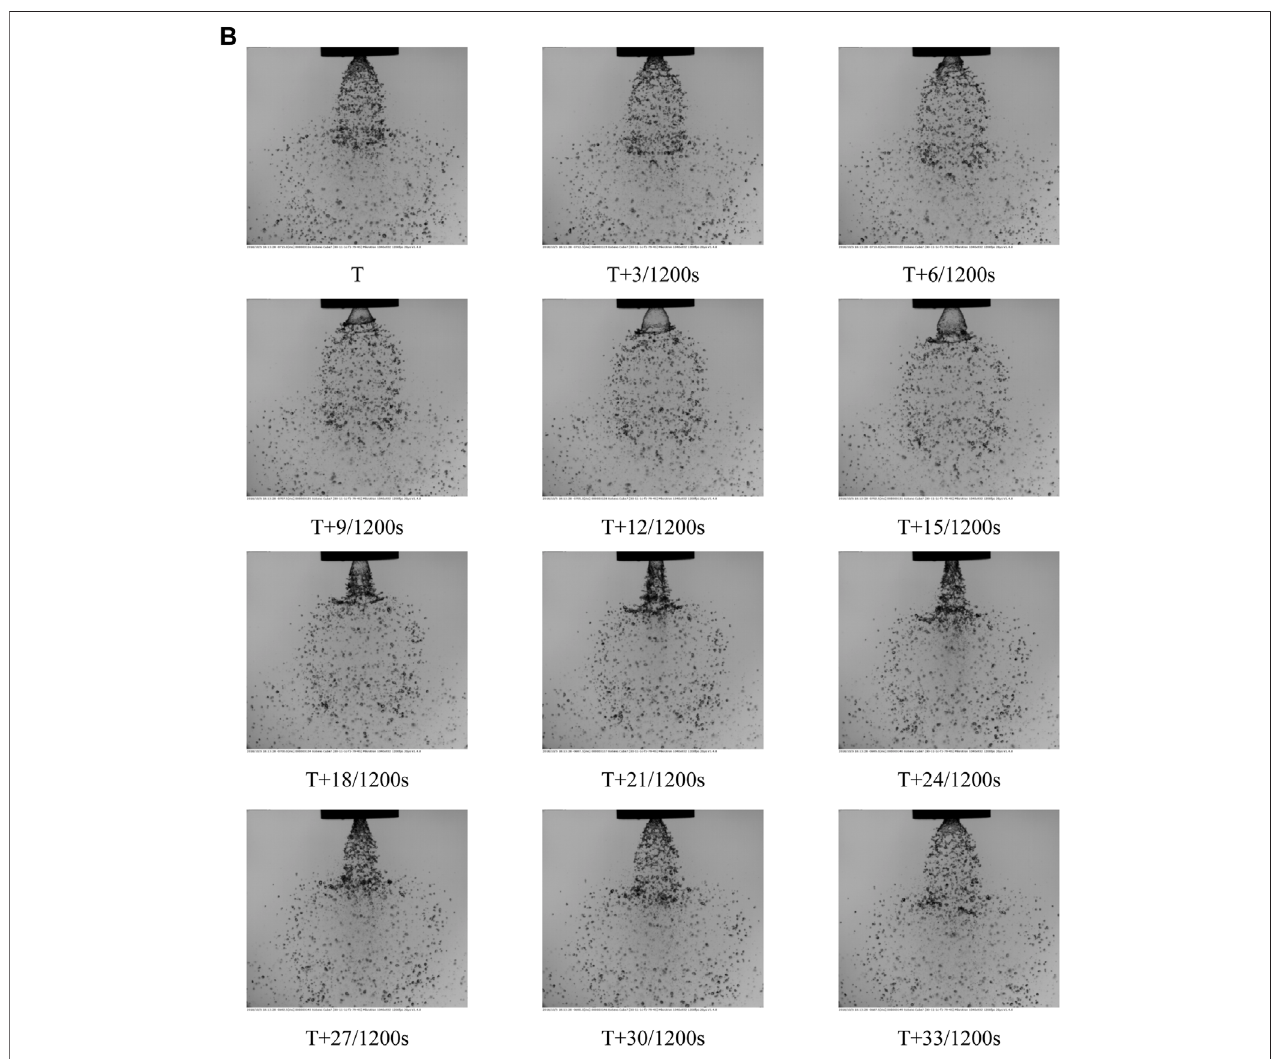
liquid fi lm morphology. The lower part of the spray then disappears and the liquid fi lm begins to break when the injector pressure drop reaches about 0.5 MPa. The spray is tulip shaped before a stable conical liquid fi lm, when the pressure drop is further increased (Surya Prakash et al.,